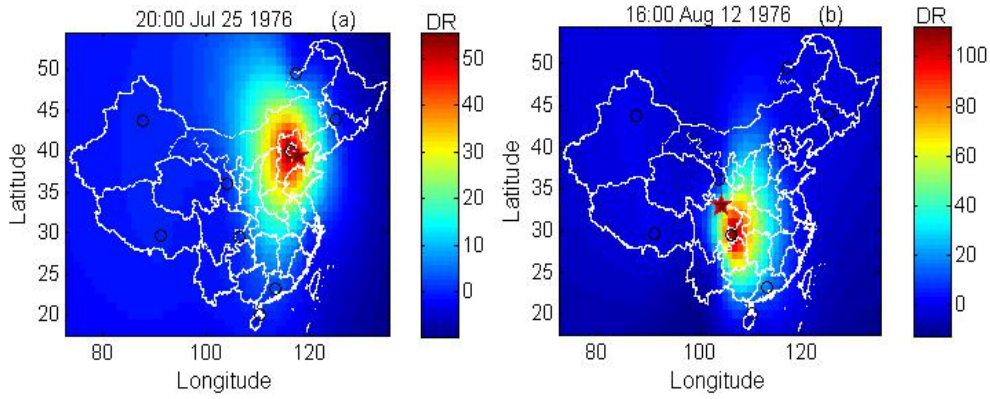
Fig. 6. Same as Fig. 3 but on 25 July (3 days prior to Tangshan earthquake occurred) and 12 August (4 days prior to Songpan earthquake occurred) of 1976.